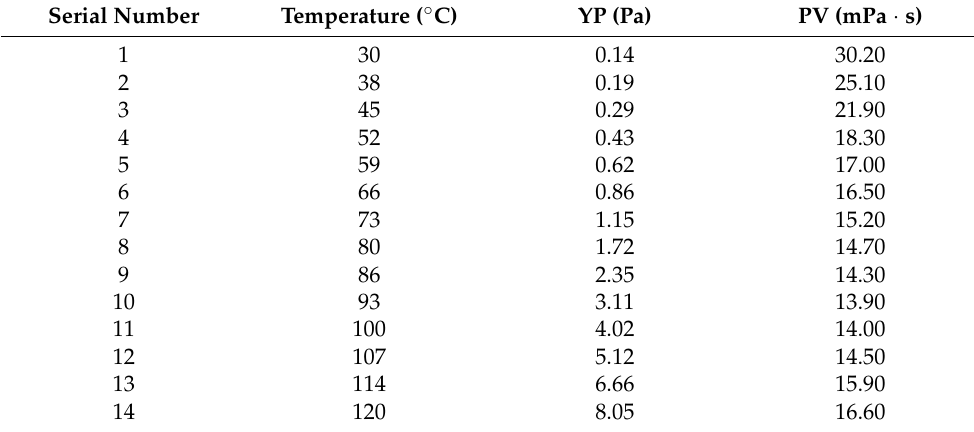
Table 2. Results of yield point and plastic viscosity of drilling fluid at different